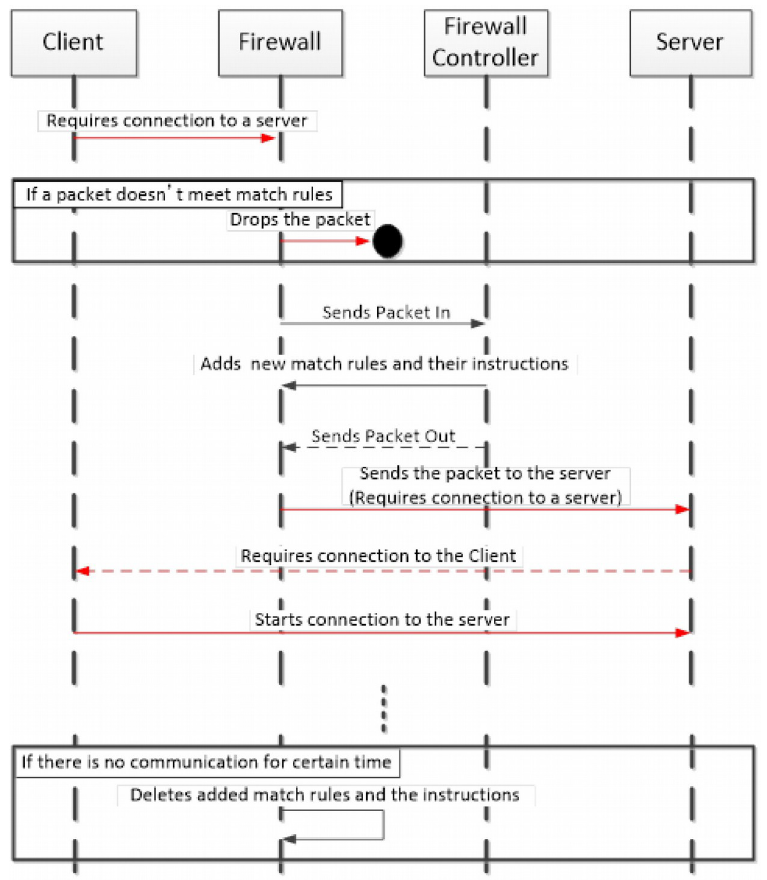
Figure 5. Communication sequence of packet